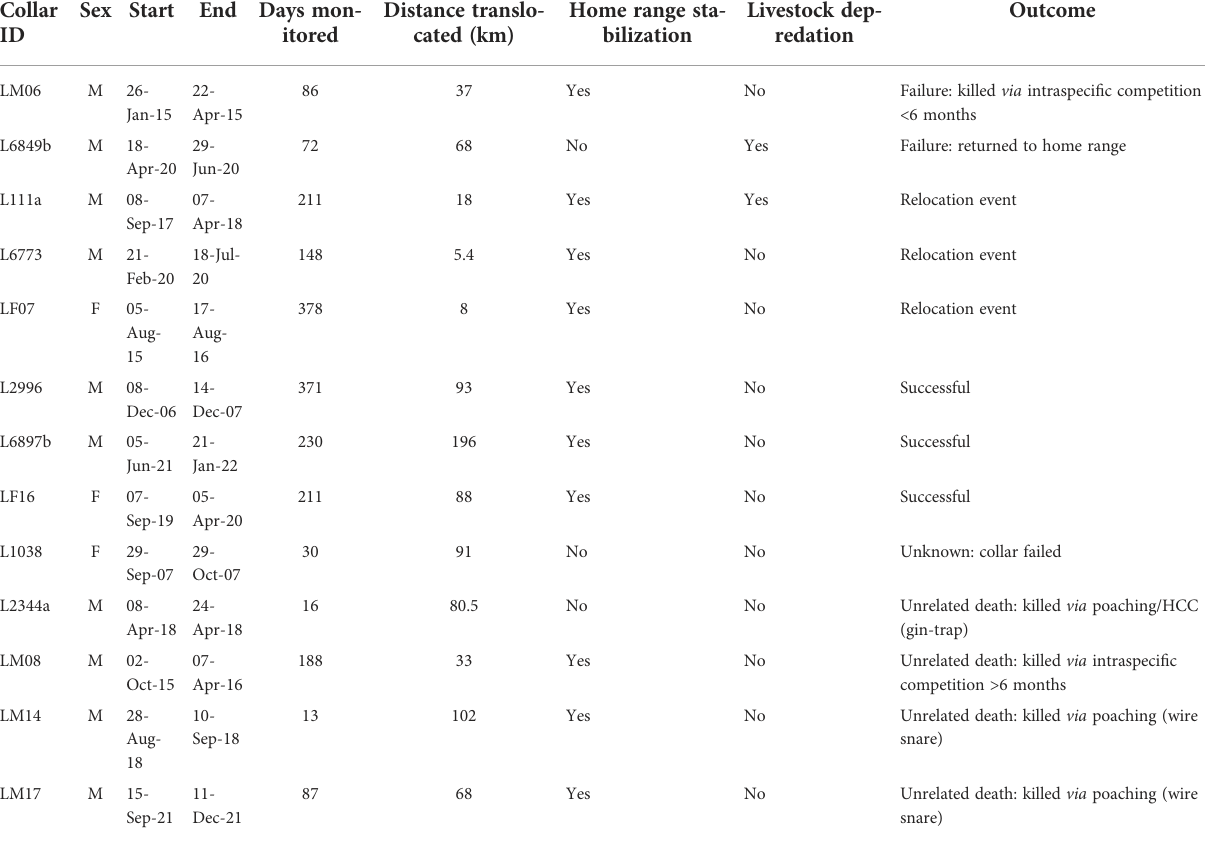
TABLE 2 Details of post-release monitoring of 13 translocated leopards fi tted with tracking collars. Collar